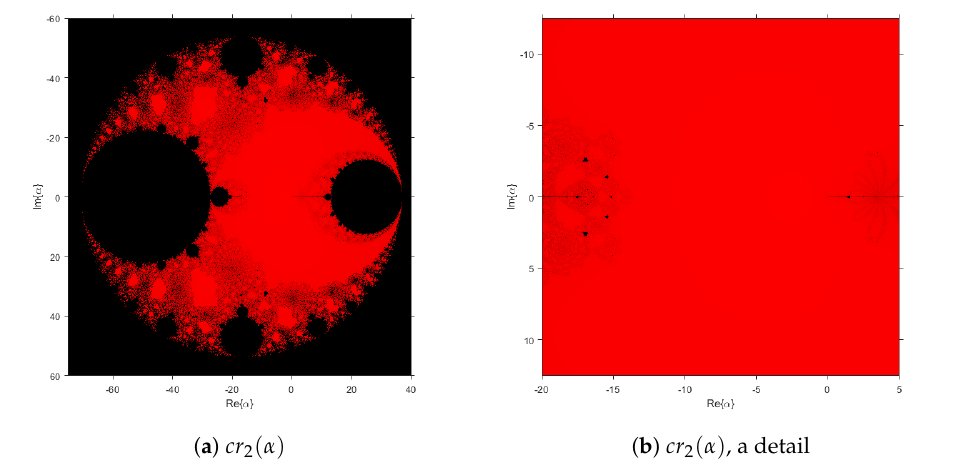
Figure 3. Parameter plane from free independent critical